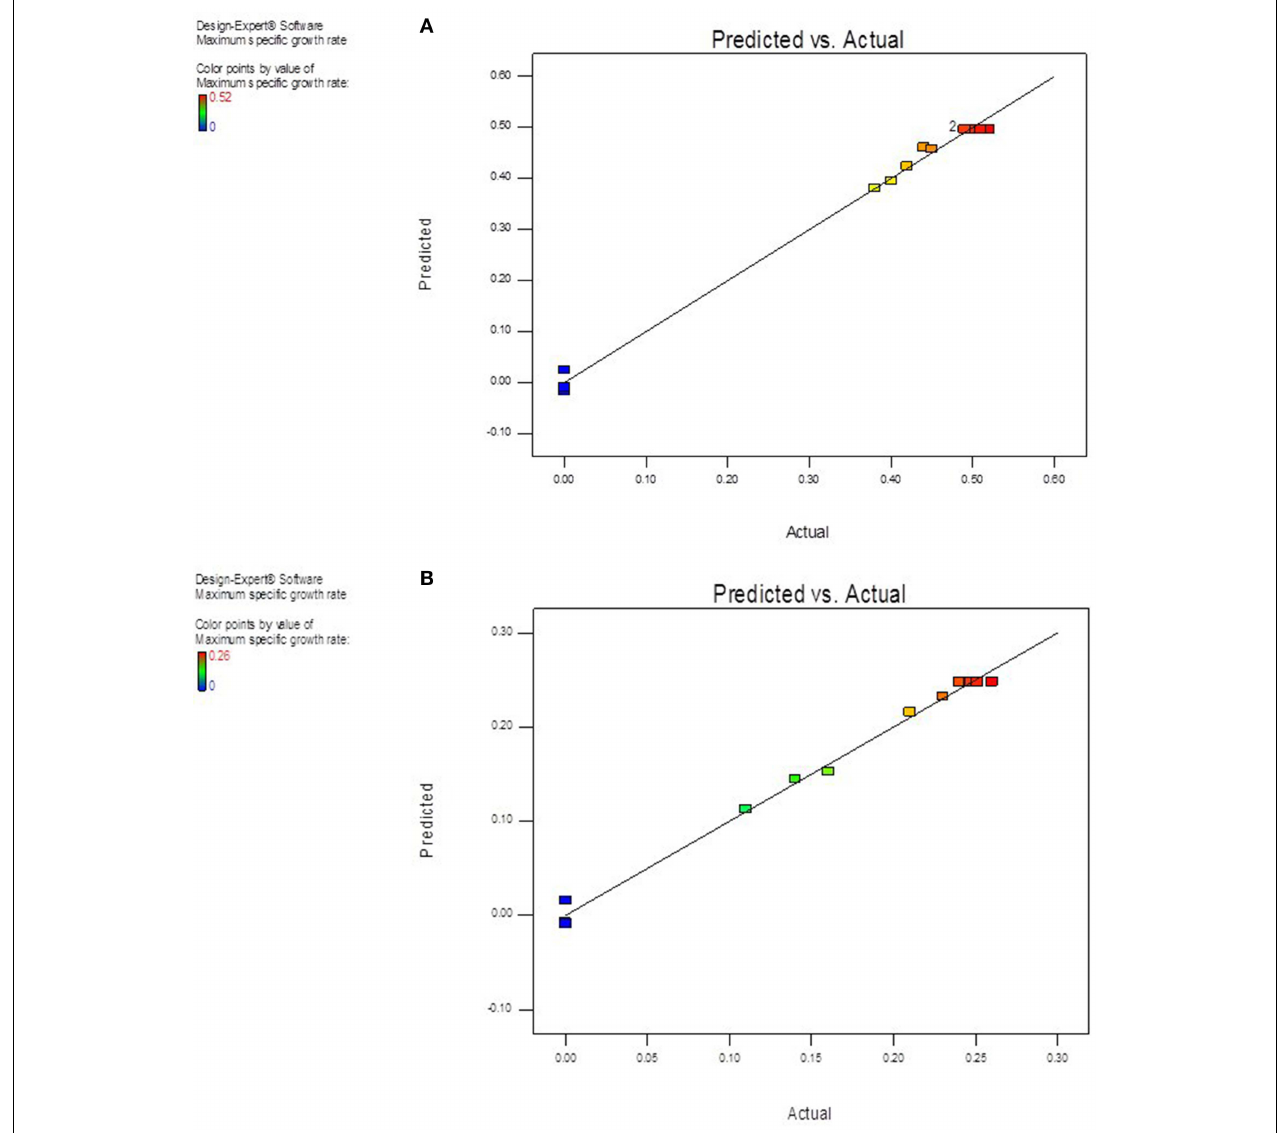
FIGURE 6 | Diagnostic plot of the distribution of observed and predicted values of maximum specific growth rate (A) K. marxianus NIRE-K1 (B) K. marxianus